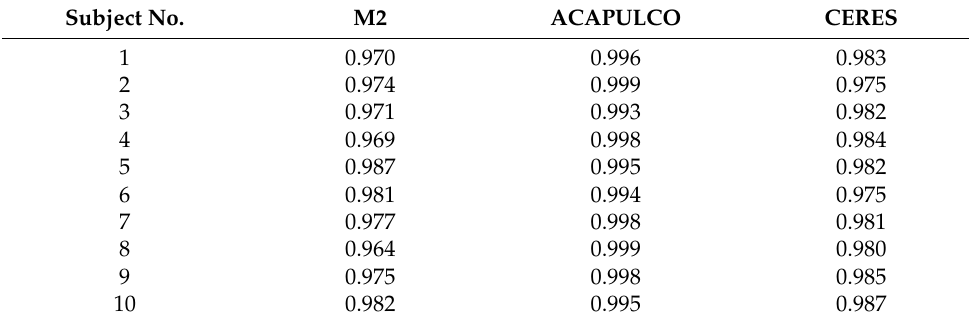
Table 8: segmentations produced by ACAPULCO and CERES include the original masks because of the problems when recognizing cerebellar fissures, resulting in elevated OC. Table 11. OC comparison between the approaches, in DLBS subset.